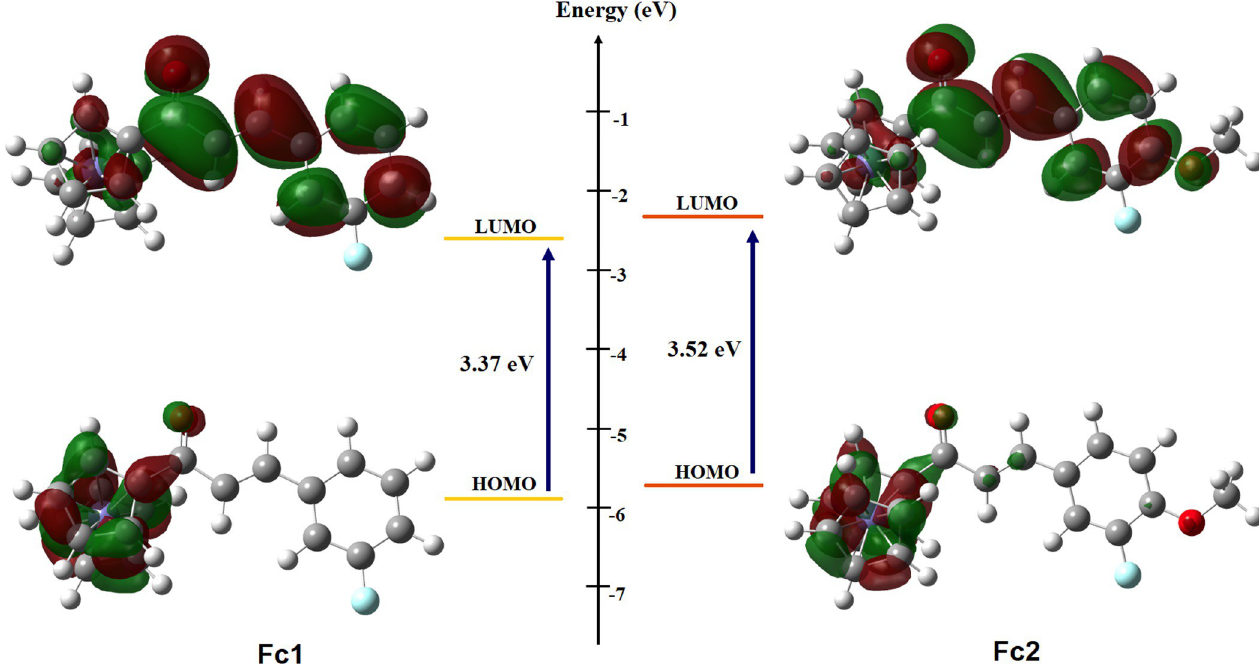
Fig 7. The orbital distribution and energy (in eV) of HOMO and LUMO for Fc1 and Fc2 computed at the B3LYP/6-311G++(d,p) level in gas phase.